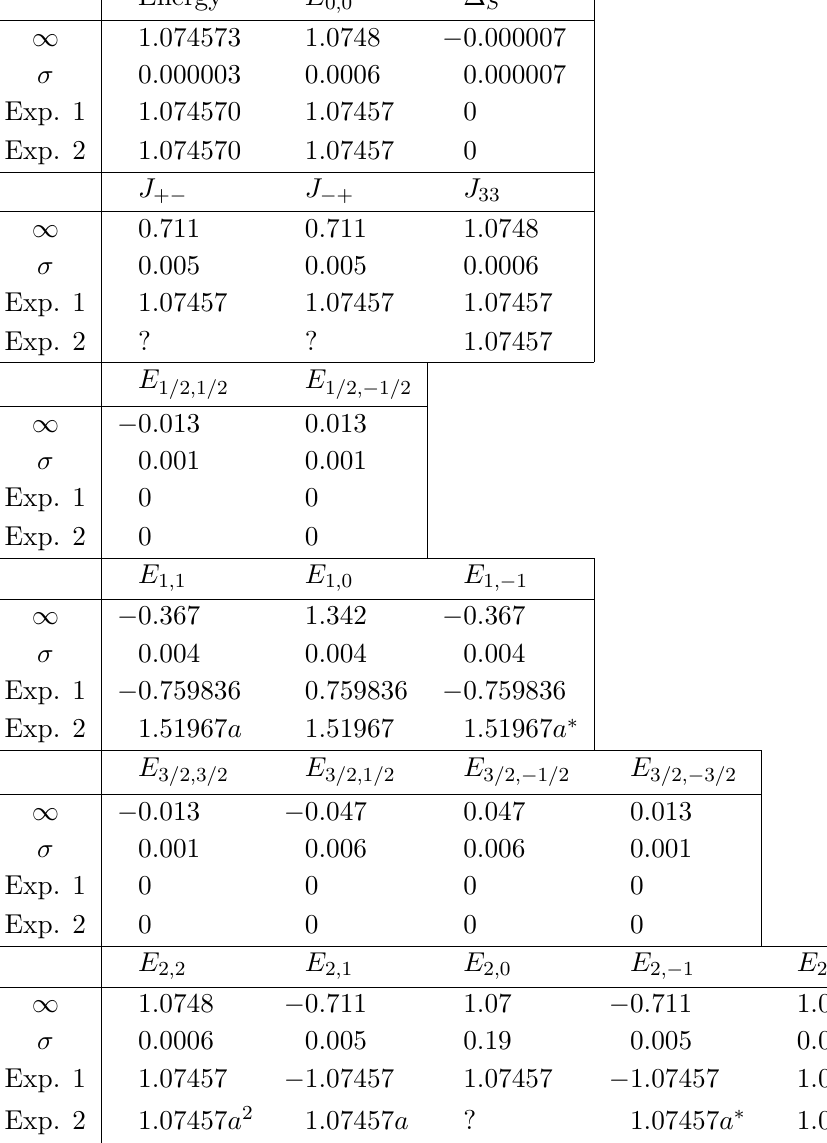
= 0 and n = 0 . The solution does not α α